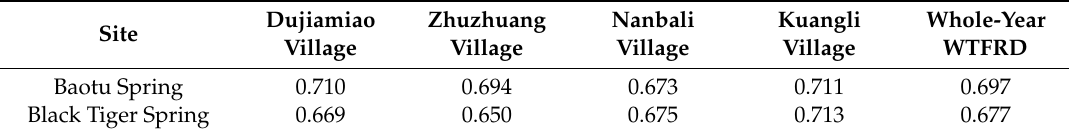
Table 4. Whole-year WTFRD from 2014 to